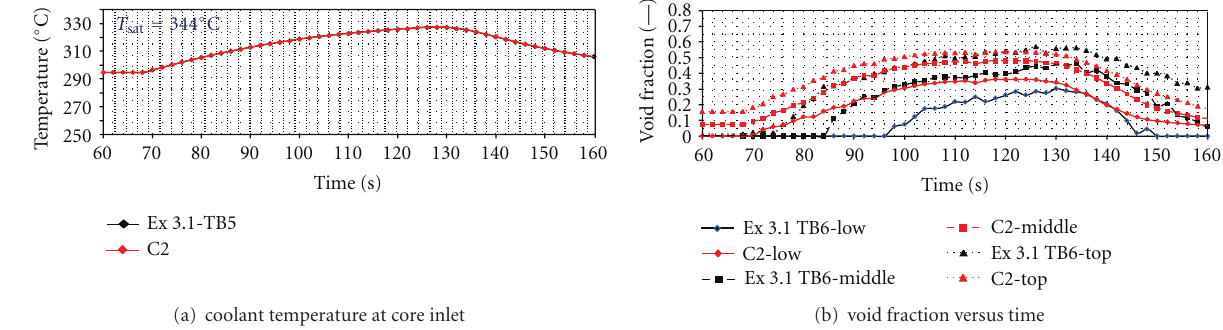
Figure 10: PSBT transient bundle tests (TS 6)—temperature increase—CATHARE2 3D: calc. versus exp., reference results (RUN131).